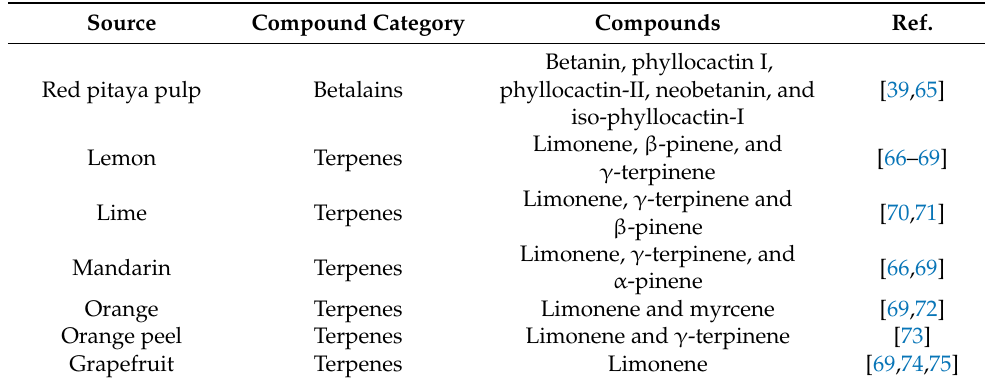
Table 2. Betalains and terpenes found in some